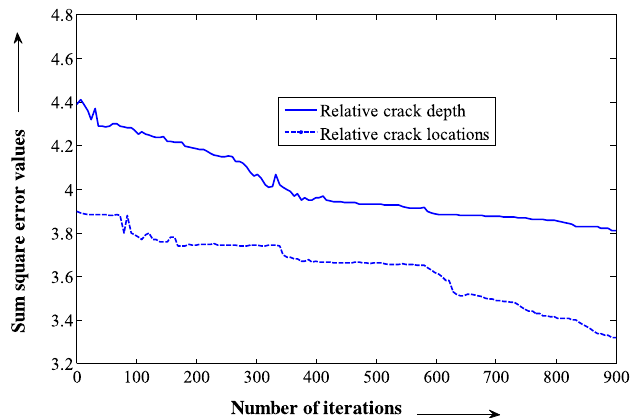
Fig. 6. Number of iterations vs. sum square err o r values (%) for relative crack depth